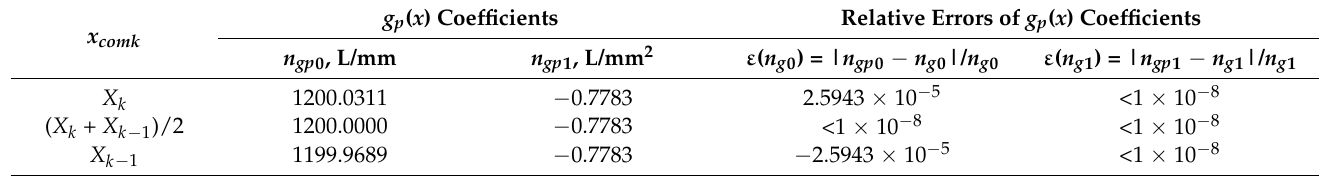
Table 1. g p (x) under the condition of f k = g ( X k ) and phase compensation with δ k . x comk g p ( x ) Coefficients